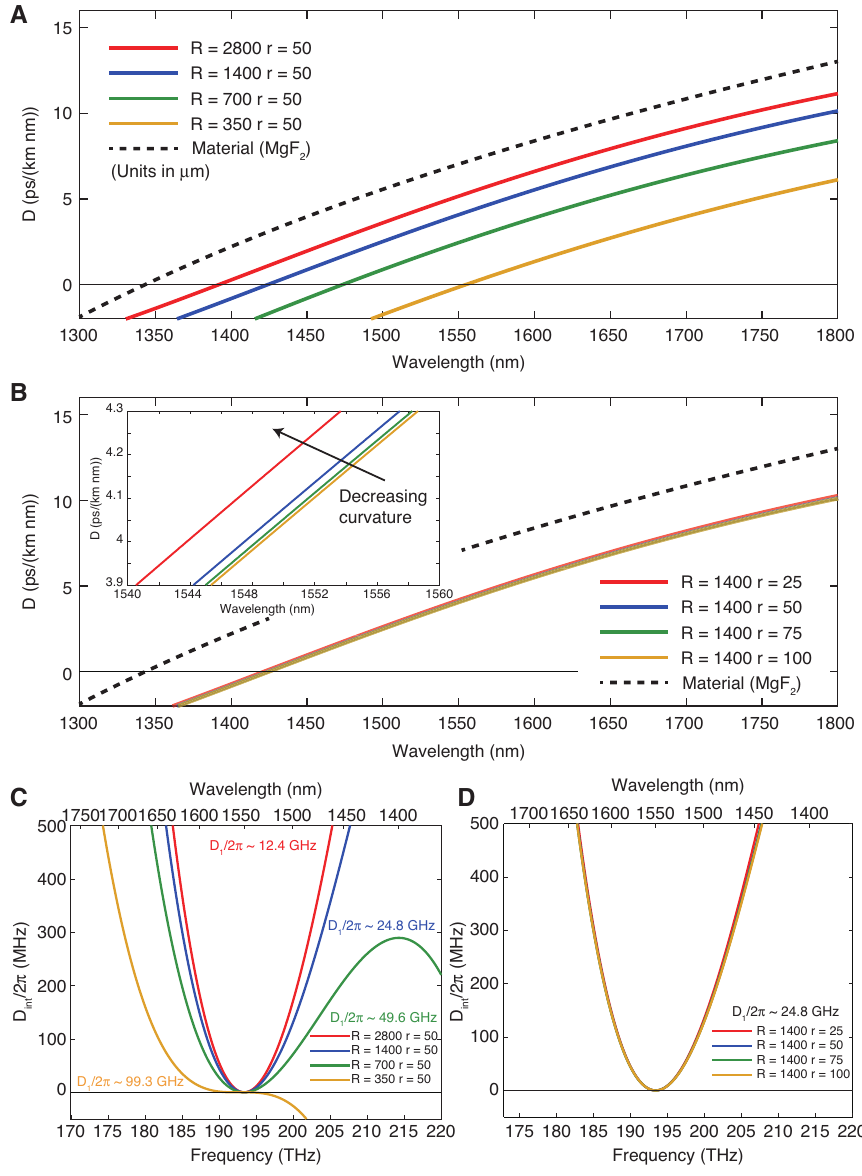
spheroid resonator for different resonator radii R and curvature radii r in μ m. Figure 7: Simulated dispersion of MgF 2 (A) Dispersion parameter D for different resonator radii. (B) Dispersion parameter D for different curvature radii. (C) Integrated dispersion D , which is defined as the deviation of the resonance frequency from an equidistant FSR, for different resonator radii. The positive int parabolic function corresponds to anomalous dispersion, and the cubic function curves of the dispersion originate from the effect of third- order dispersion. (D) Integrated dispersion D for different curvature int